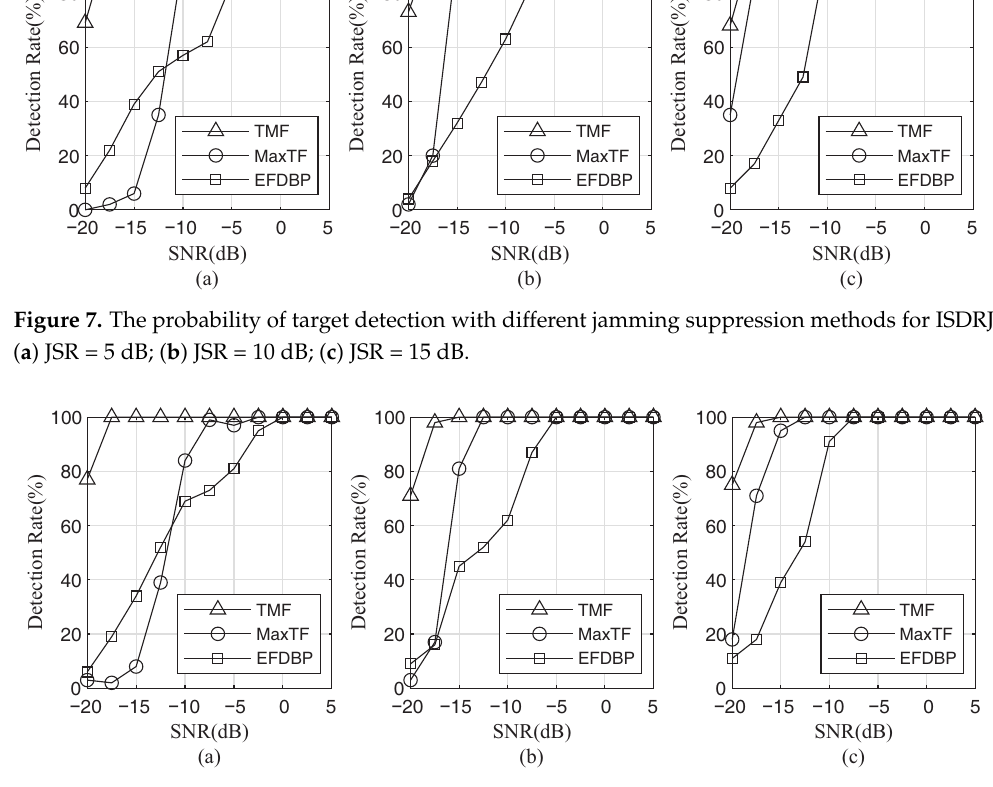
Figure 8. The probability of target detection with different jamming suppression methods for ISPRJ.